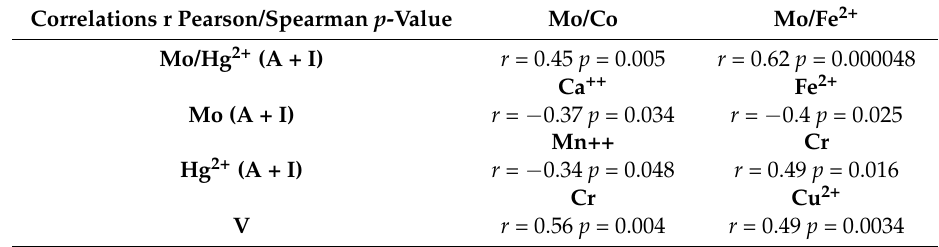
Table 5. Correlations between Mo/Hg 2+ , Mo/Co, Mo/Fe 2+ ratios in the A + I group by r Pearson or r